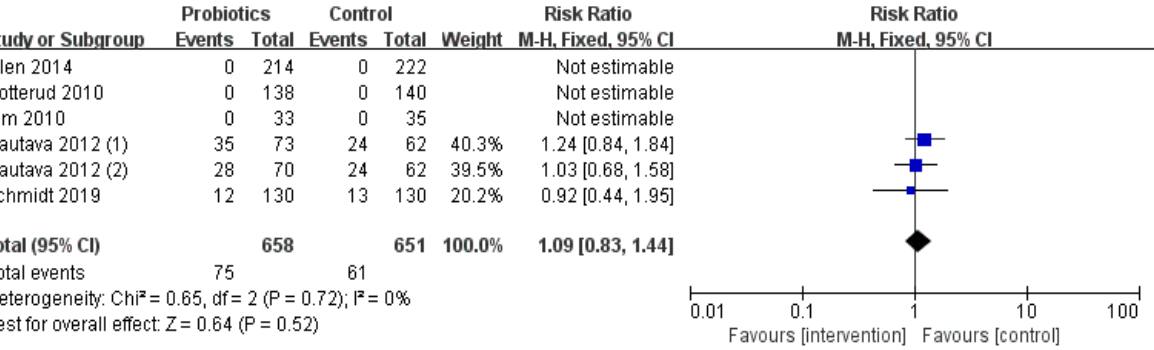
Figure 5. The occurrence of adverse events during the intervention.